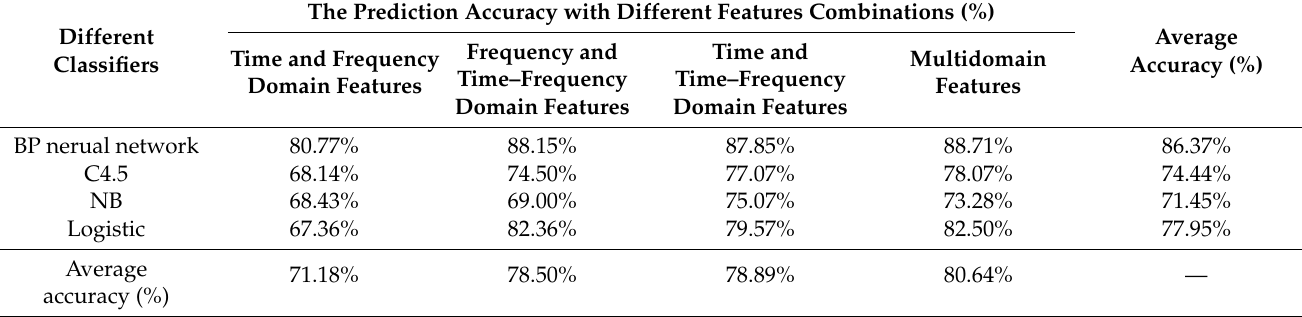
Table 7. Classification accuracy of different classifiers with different domain feature